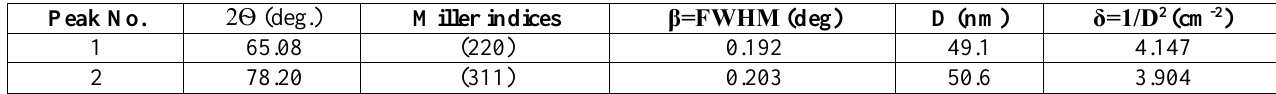
Table 2: X-ray diffraction peaks of Al bulk.